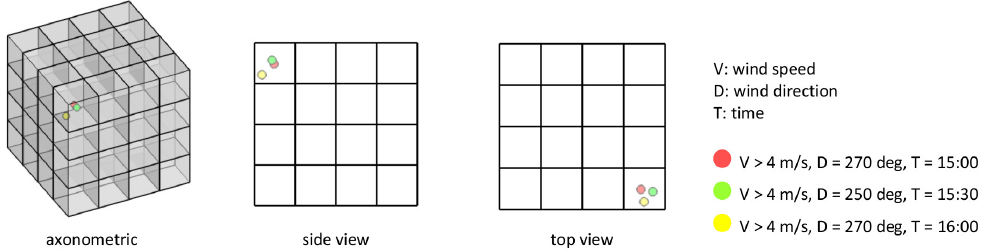
Figure 4. A 3D feature grid with three historical events in a cell. The dots represent the locations of the velocity vectors. The red and yellow vector are results of the same CFD simulation since they are produced from the same wind direction (assuming the same wind speed in the historical data).